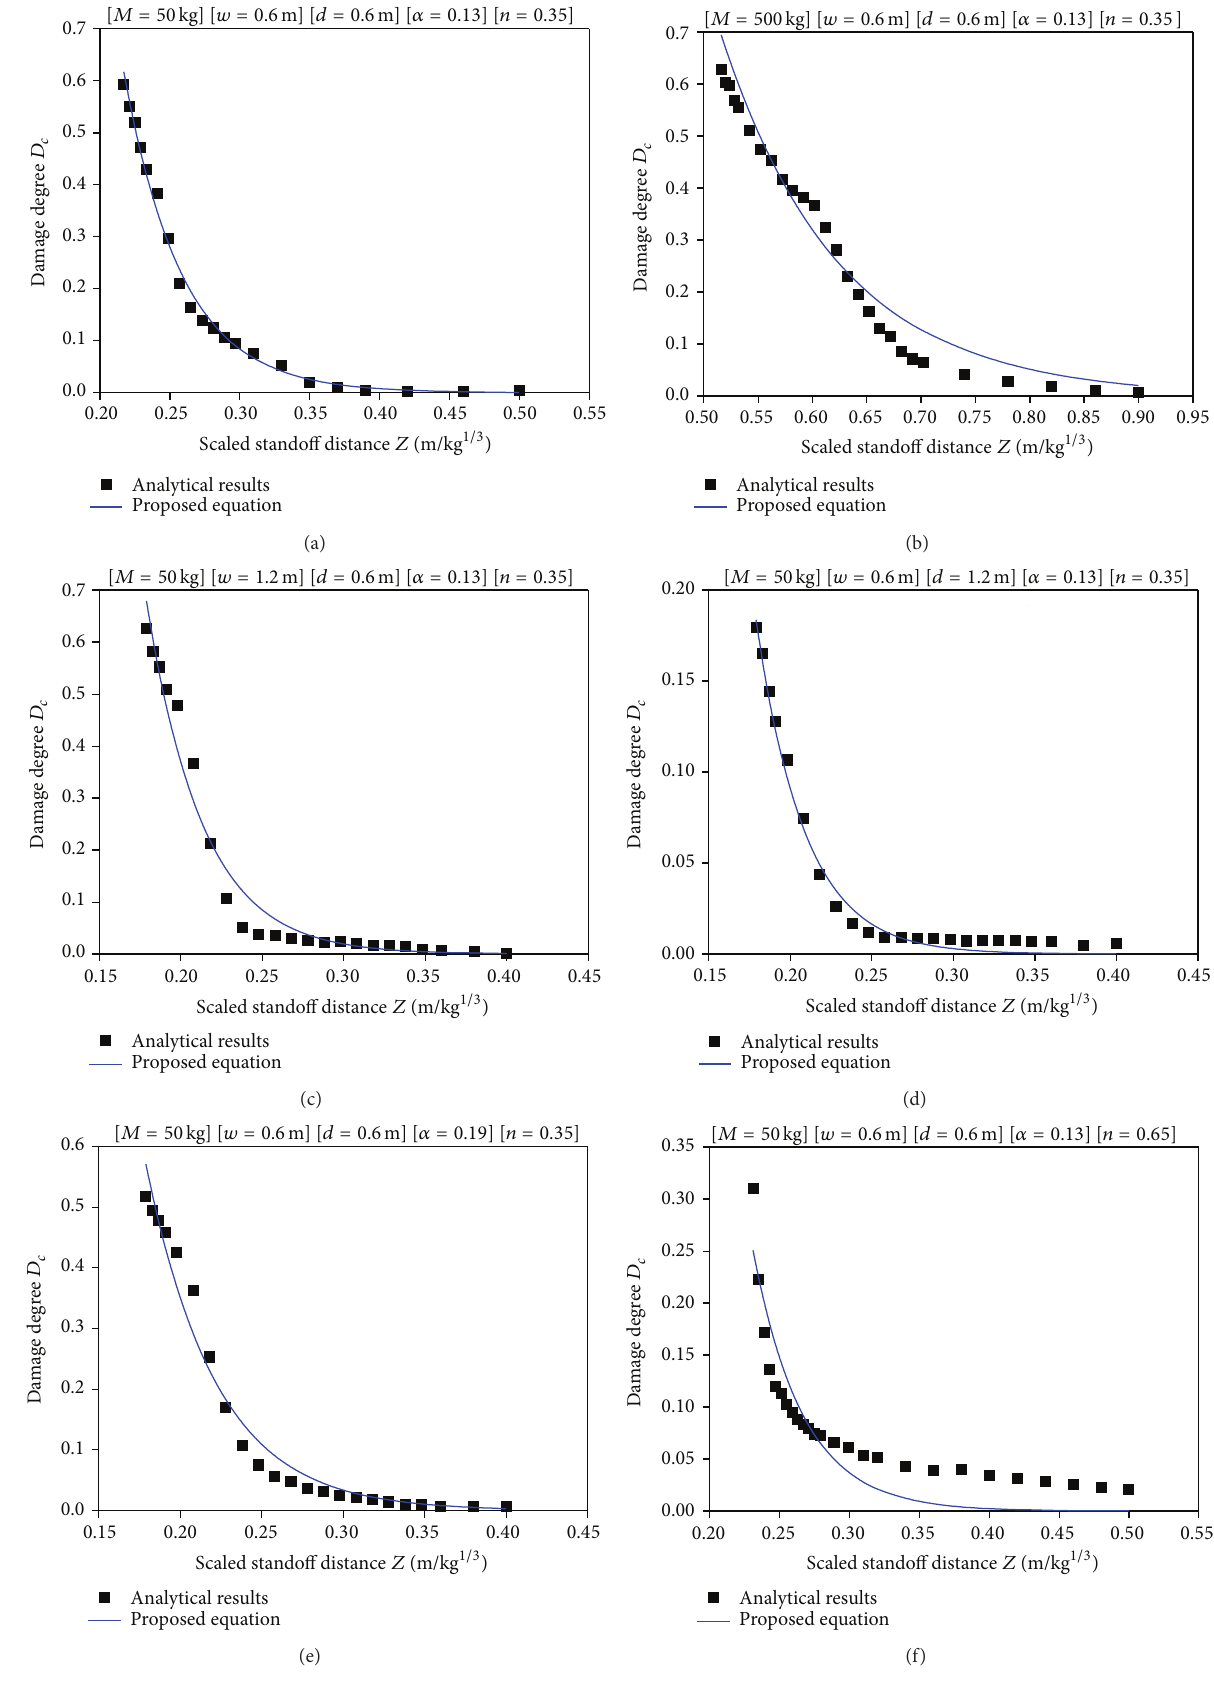
Figure 15: Comparison of analytical results with the proposed